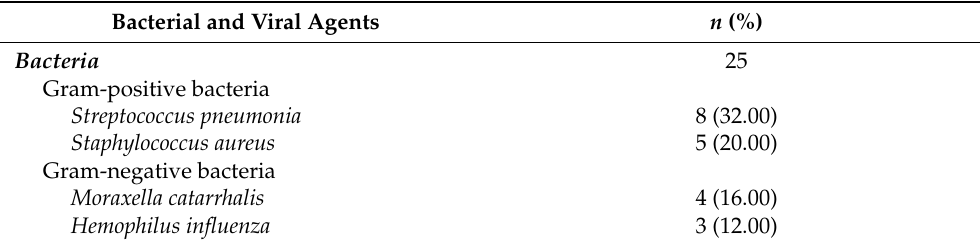
Table 5. Bacterial and viral agents found in children with febrile